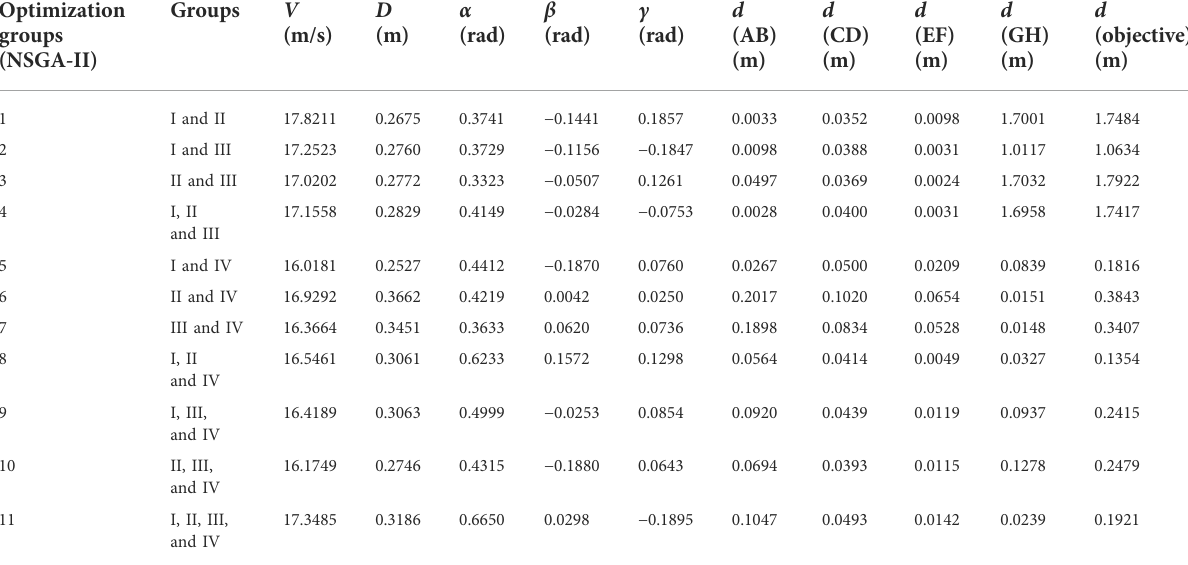
TABLE 5List ofthe globaloptimalsolution parametersof 11optimizationgroupsbasedon the numberofcollisionmarkerpairs andcollision contact types by NSGA-II. Optimization